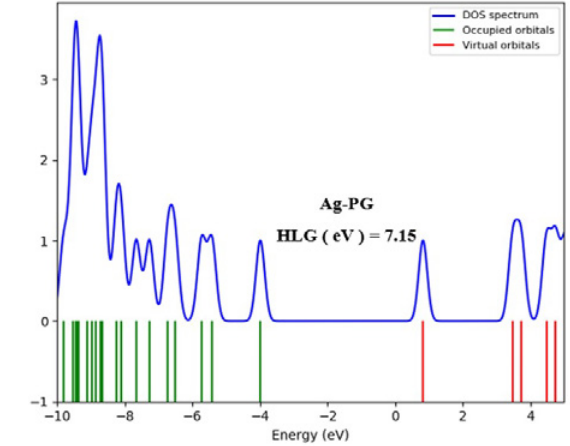
Fig. 5. DOS diagram of Ag-PG